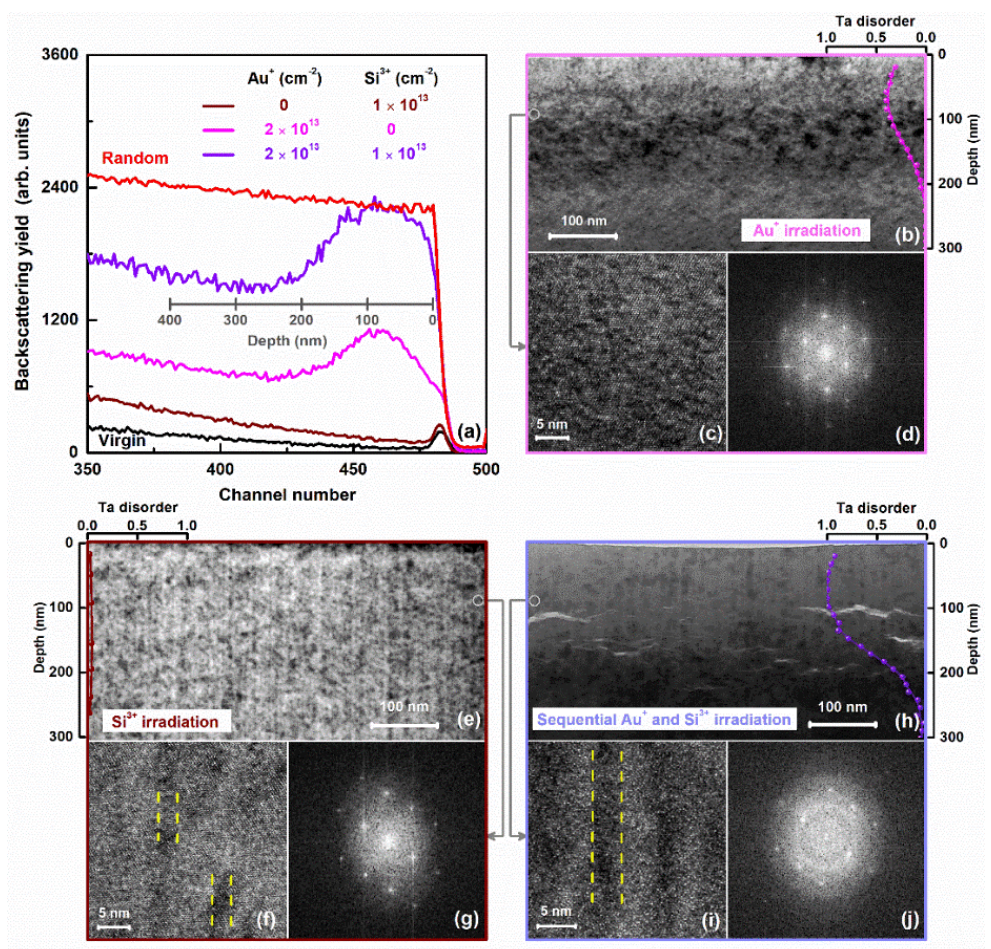
Figure 4. ( a ) RBS / channeling spectra of pristine and predamaged LiTaO 3 samples under subsequent Figure 4. ( a ) RBS/channeling spectra of pristine and predamaged LiTaO 3 samples under subsequent 0.71 MeV / u Si 3 + irradiation with an E ele of 6.2 keV / nm. Cross-sectional TEM images and 0.71 MeV/u Si 3+ irradiation with an E ele of 6.2 keV/nm. Cross-sectional TEM images and corresponding